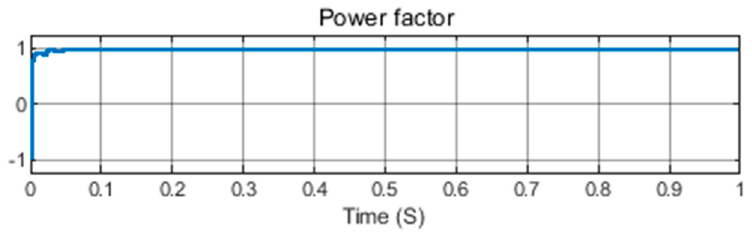
Figure 21. The power factor of the photovoltaic power plant (PVPP) at rated inverter output power.